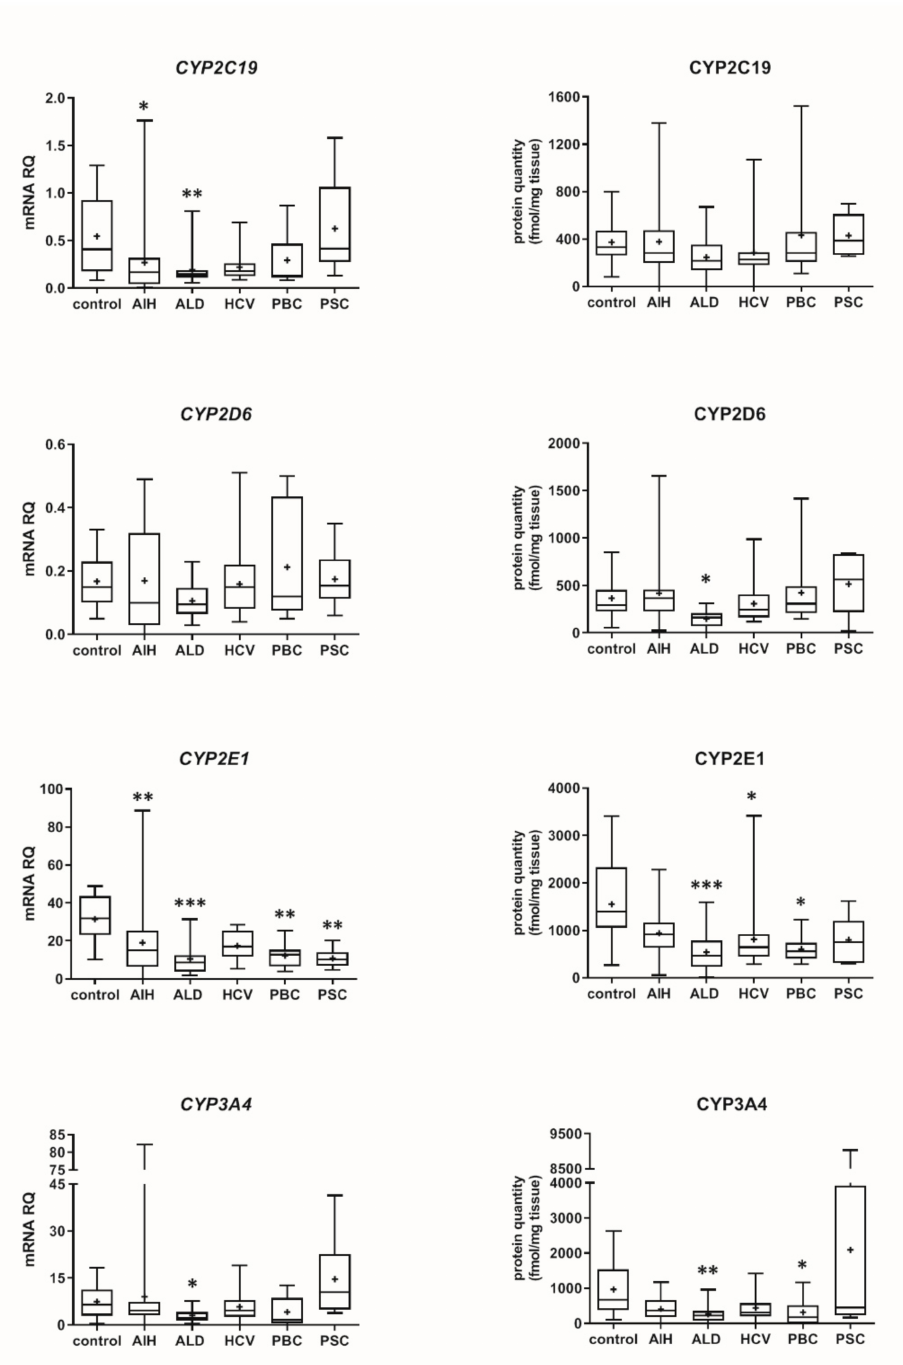
Figure 4. (also see page up) Gene expression ( left ) and protein abundance ( right ) of CYPs in hepatic tissues from hepatitis C (HCV, n = 21), primary biliary cholangitis (PBC, n = 10), primary sclerosing cholangitis (PSC, n = 6), alcoholic liver disease (ALD, n = 20) and autoimmune hepatitis (AIH, n = 20) patients and the controls ( n = 20). The data are represented as box-plots of the median (horizontal line), 75th (top of box), and 25th (bottom of box) quartiles, the smallest and largest values (whiskers) and mean (+) are shown. mRNA levels of the analyzed genes were expressed as relative amounts to the mean of five housekeeping genes ( GAPDH , HMBS , PPIA , RPLP0 , RPS9 ). Statistically significant differences: * p < 0.05, ** p < 0.01, *** p < 0.001 (Kruskal–Wallis test post hoc Dunn’s test with Bonferroni correction) in comparison to the